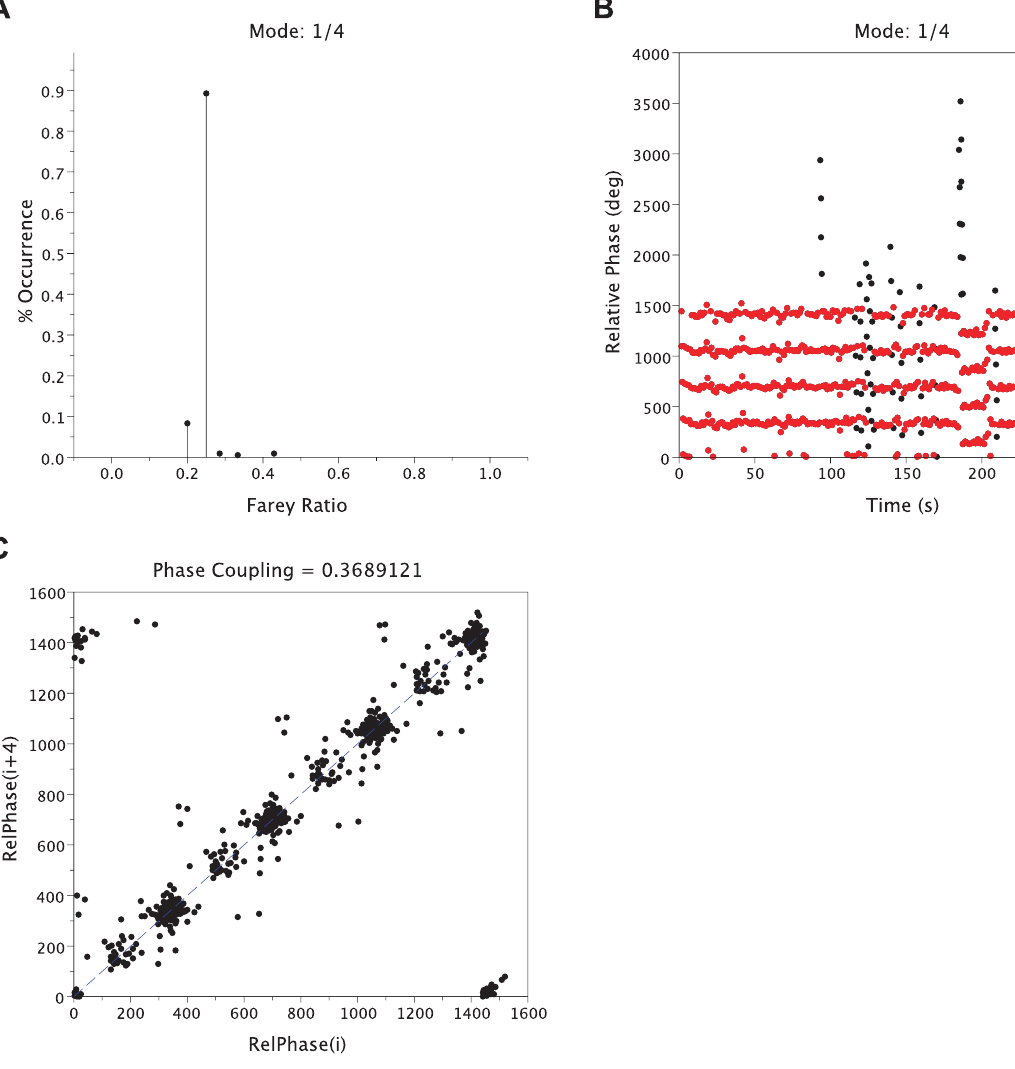
Figure 3. Locomotor-Respiratory coupling (LRC) from one typical participant in one trial. A: modal frequency ratio distribution extracted from the Farey tree (mode=1/4, level 4). B: 5-minutes evolution of relative phase values where red dots represent the relative phase values for the modal frequency ratio and black dots represent the relative phase values for the remaining frequency ratios. C. Return Map assessing the strength of the phase-coupling by measuring the dispersion of the relative phase values around the identity line.